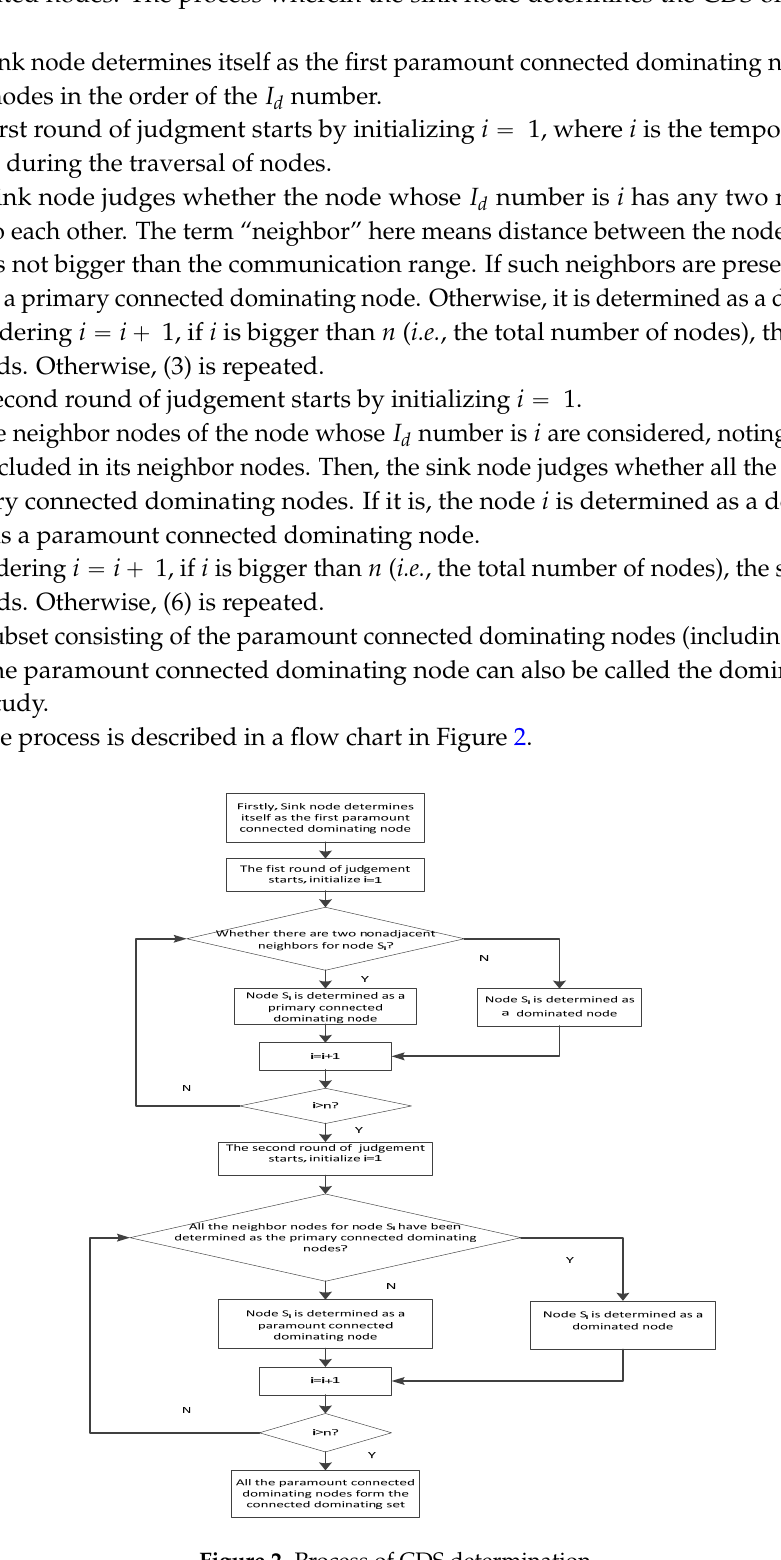
Figure 2. Process of CDS determination.